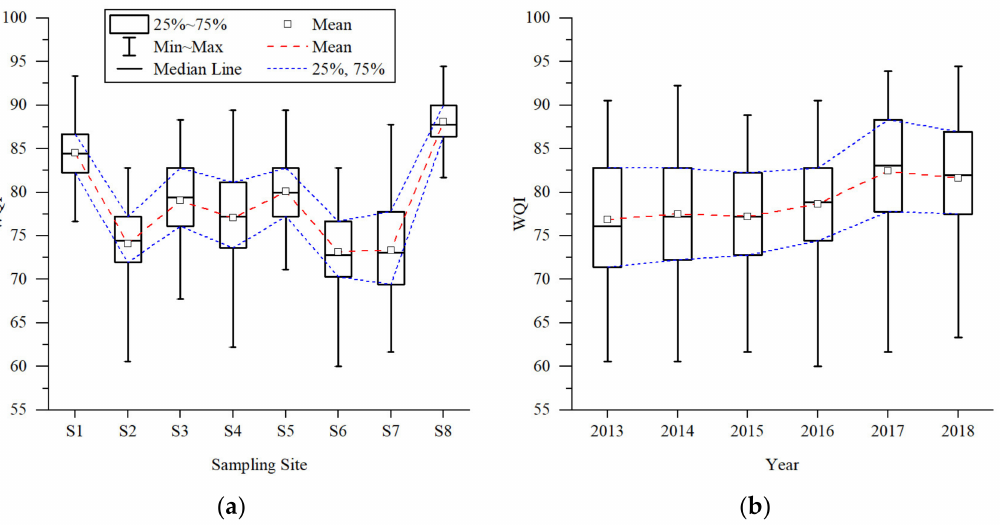
Figure 4. Box charts for WQIs of sampling sites ( a ) and study period ( b